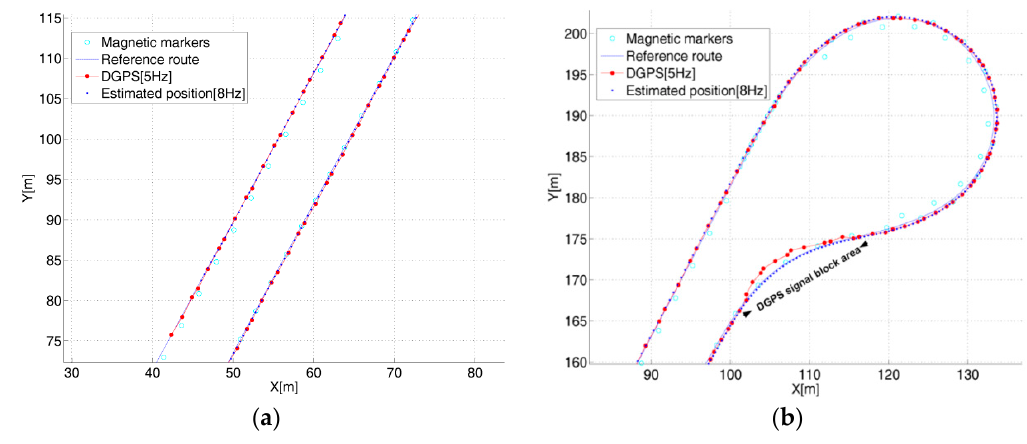
Figure 11. GPS position and estimated position. ( a ) Position estimation on the straight route; ( b ) Position estimation on the upside curve.